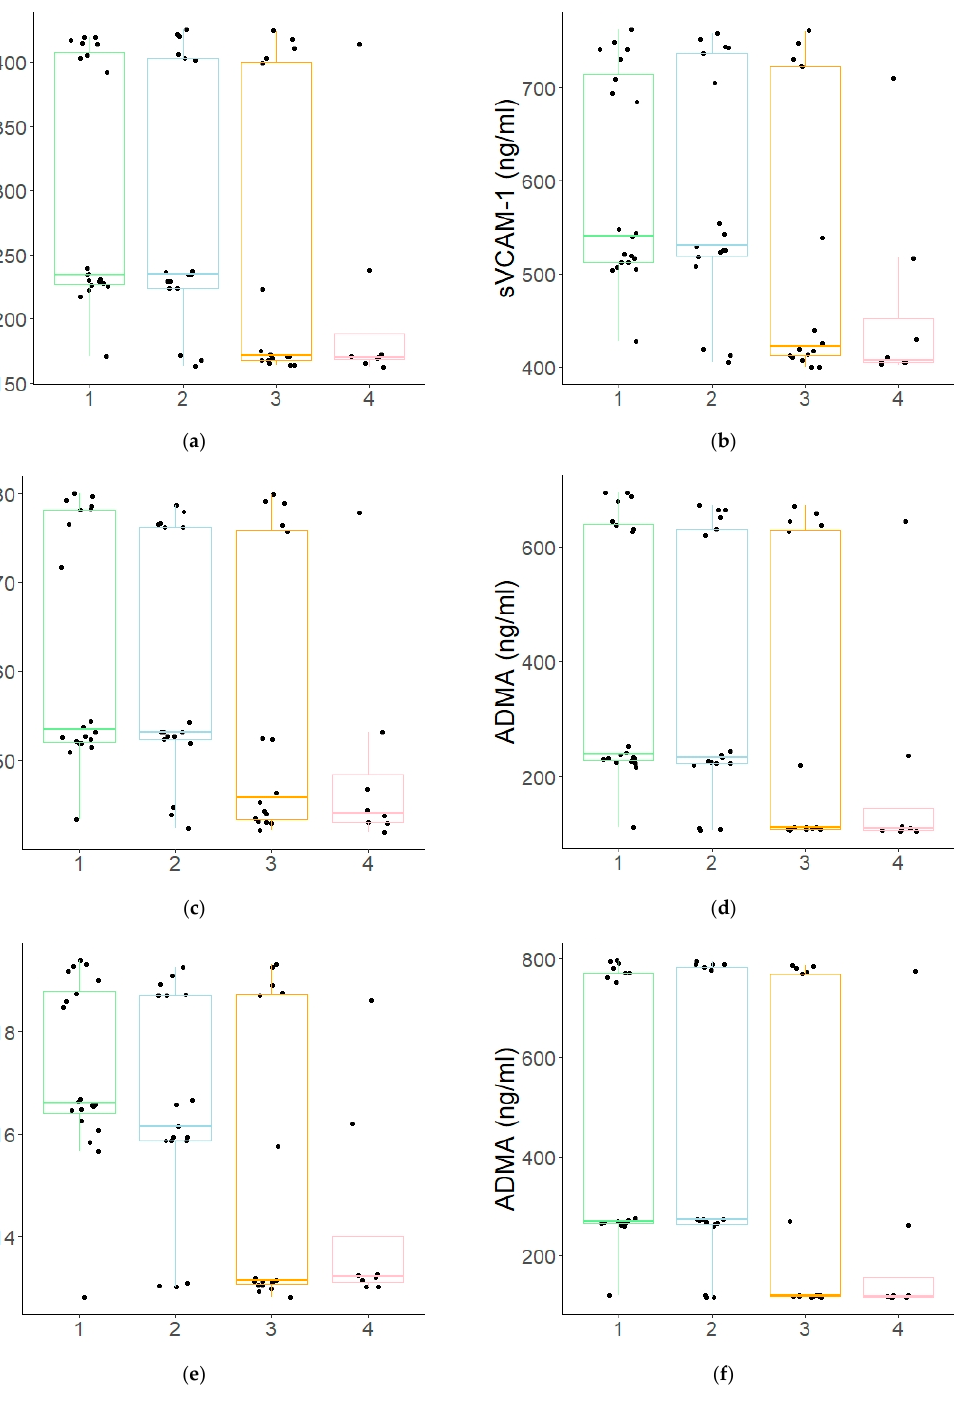
Figure 4. ( a – f ). A comparison of endothelial damage markers depending on the degree of metabolic (non)balancing of type 1 diabetes (( a )—the mean sICAM-1 values: 298.69 ± 95.06 vs. 284.13 ± 101.18 vs. 247.87 ± 114.65 vs. 207.70 ± 86.90 ng/mL; ( b )—the mean sVCAM-1 values: 598.80 ± 111.06 vs. 583.04 ± 127.85 vs. 523.53 ± 152.63 vs. 461.07 ± 108.22 ng/mL; ( c )—the mean sE-SELECTIN values: 62.13 ± 13.35 vs. 59.81 ± 13.58 vs. 55.57 ± 15.92 vs. 49.24 ± 12.07 ng/mL; ( d )—the mean ADMA values: 397.44 ± 223.47 vs. 356.19 ± 228.50 vs. 284.21 ± 254.30 vs. 191.14 ± 188.38 ng/mL; ( e )—the mean PAI-1 values: 17.23 ± 1.70 vs. 16.56 ± 2.12 vs. 15.08 ± 2.80 vs. 4.22 ± 2.07 ng/mL; ( f )—the mean RAGE values: 462.95 ± 265.67 vs. 424.01 ± 281.86 vs. 333.59 ± 312.73 vs. 216.76 ± 231.39 pg/mL). Boxplot of values for each subgroup. Legends: 1—the patients with HbA1c: 6.5–8.9%, n = 20; 2—the patients with HbA1c: 9–11.4%, n = 17; 3—the patients with HbA1c: 11.5–13.9%, n = 16; 4—the patients with HbA1c: ≥ 14%, n =